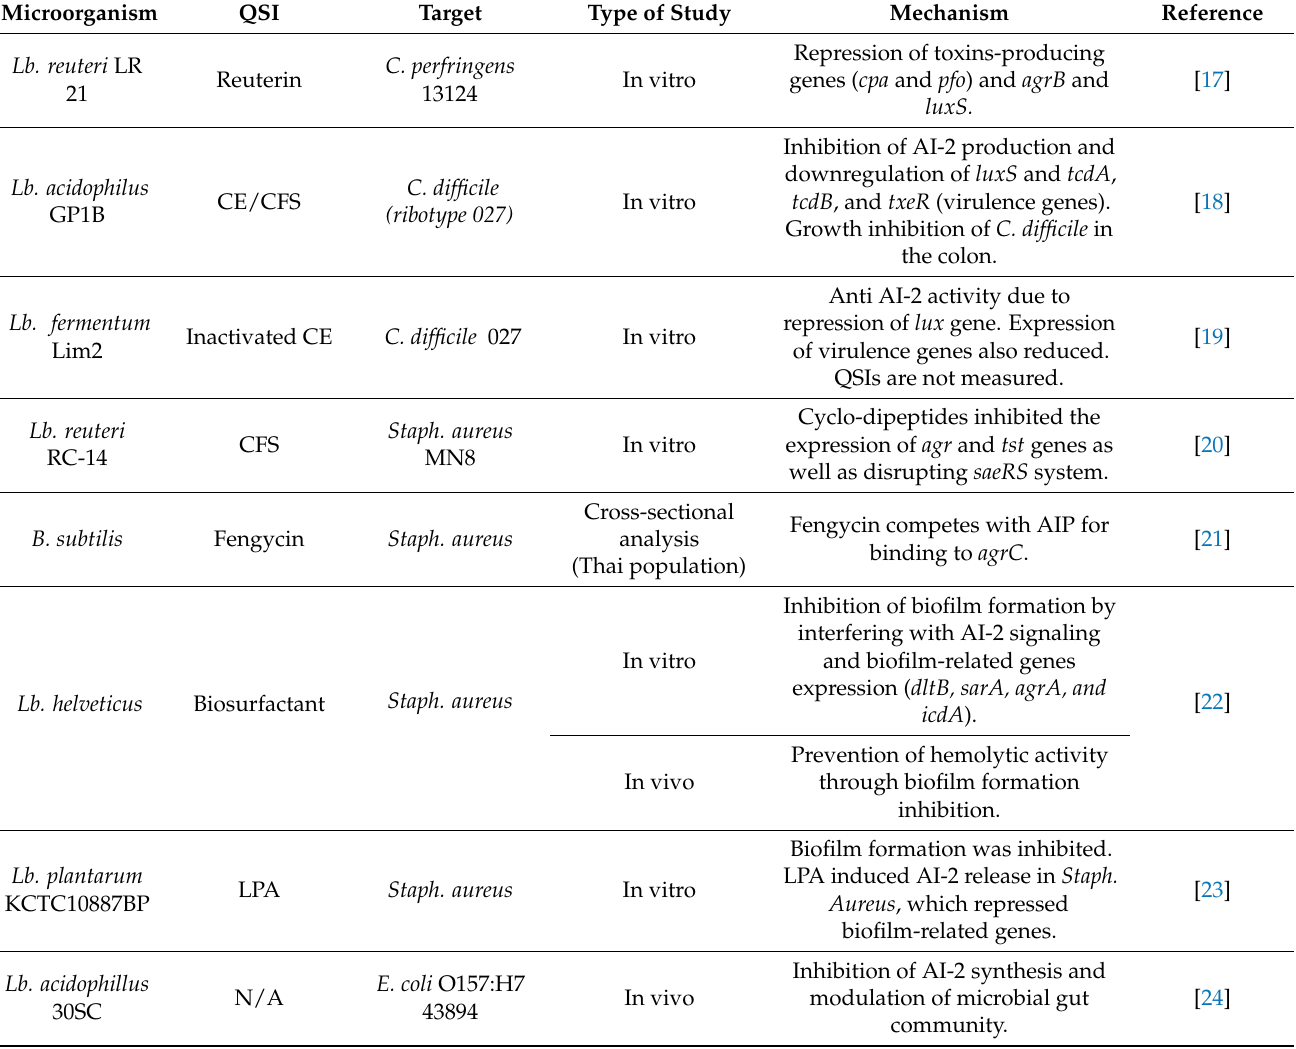
Table 1. Probiotics involved in the inhibition of QS mechanisms of foodborne pathogenic